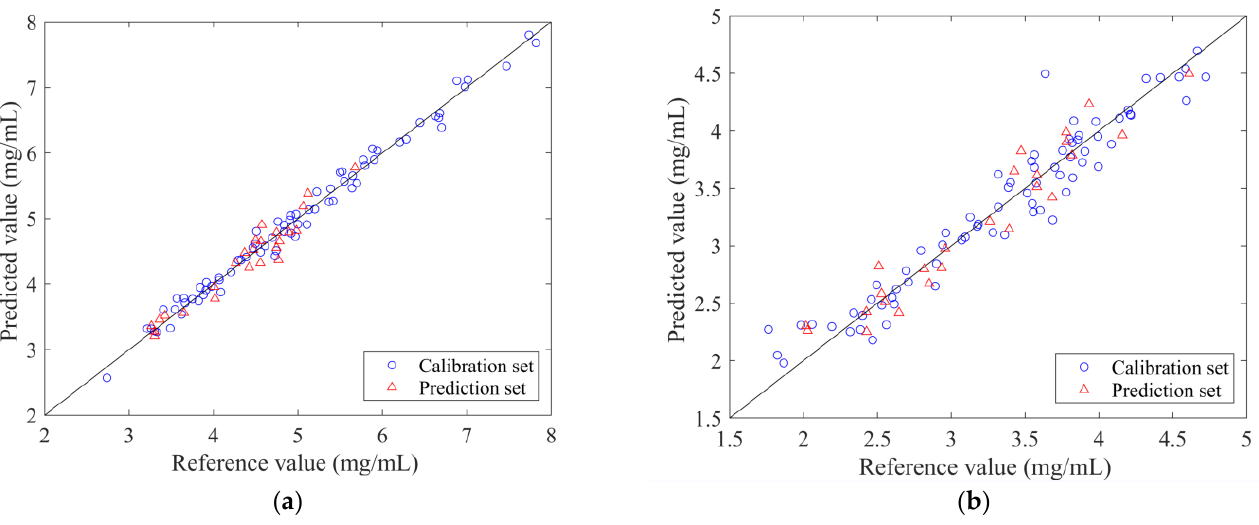
Figure 8. Scatter plot of reference measurements and NIR prediction. ( a ) geniposide; ( b ) baicalin. Table 5. The results of external validation of VCPA-IRIV-PLSR models.